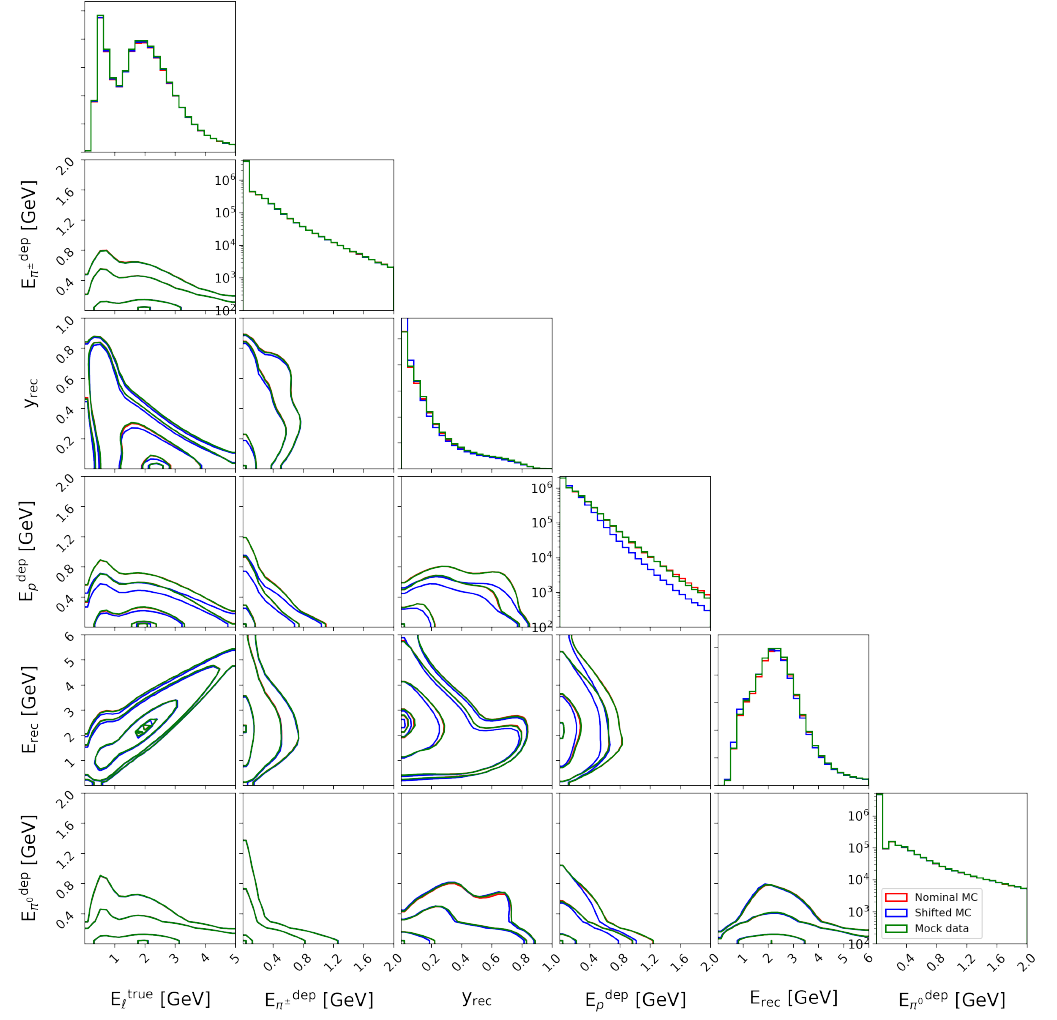
Figure 93. Multidimensional distribution of observables in FHC for the nominal sample (red), the mock data set before (blue) and after (green) reweighting. The histograms on top of the columns show one-dimensional projections of the distribution and the others show contours in pairwise two-dimensional